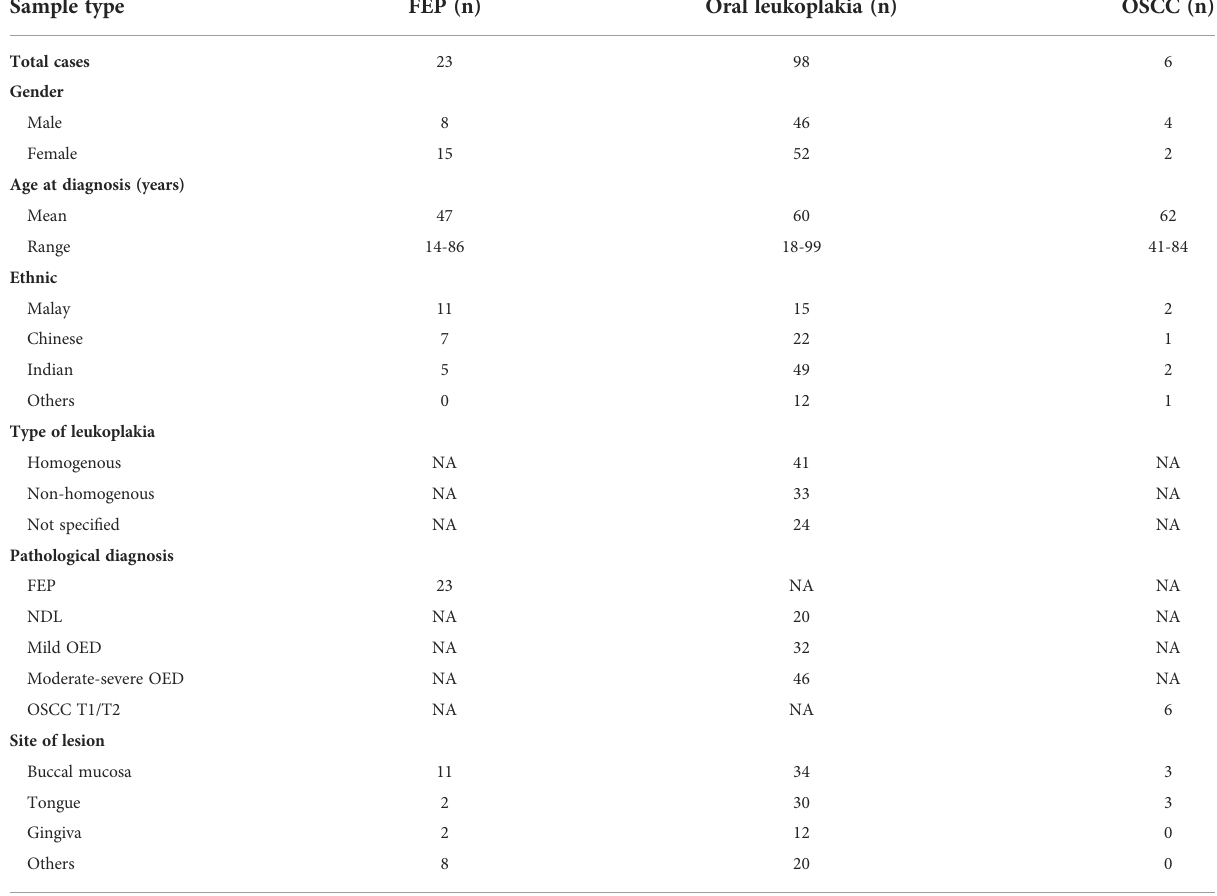
TABLE 1 Patient demographics and clinical information for cases and